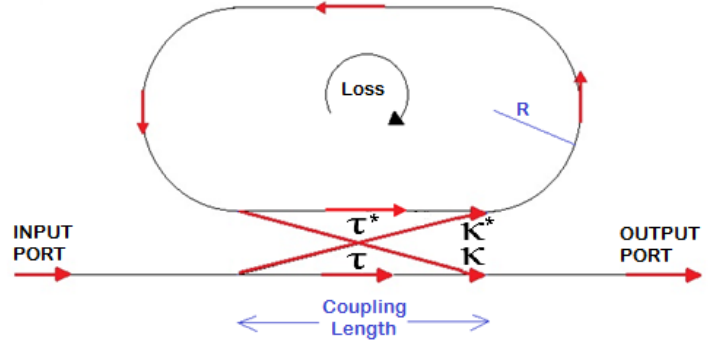
Figure 1. Sketch of a racetrack resonator characterized by a directional coupler ( the * denotes the conjugated complex value of τ and κ , respectively).